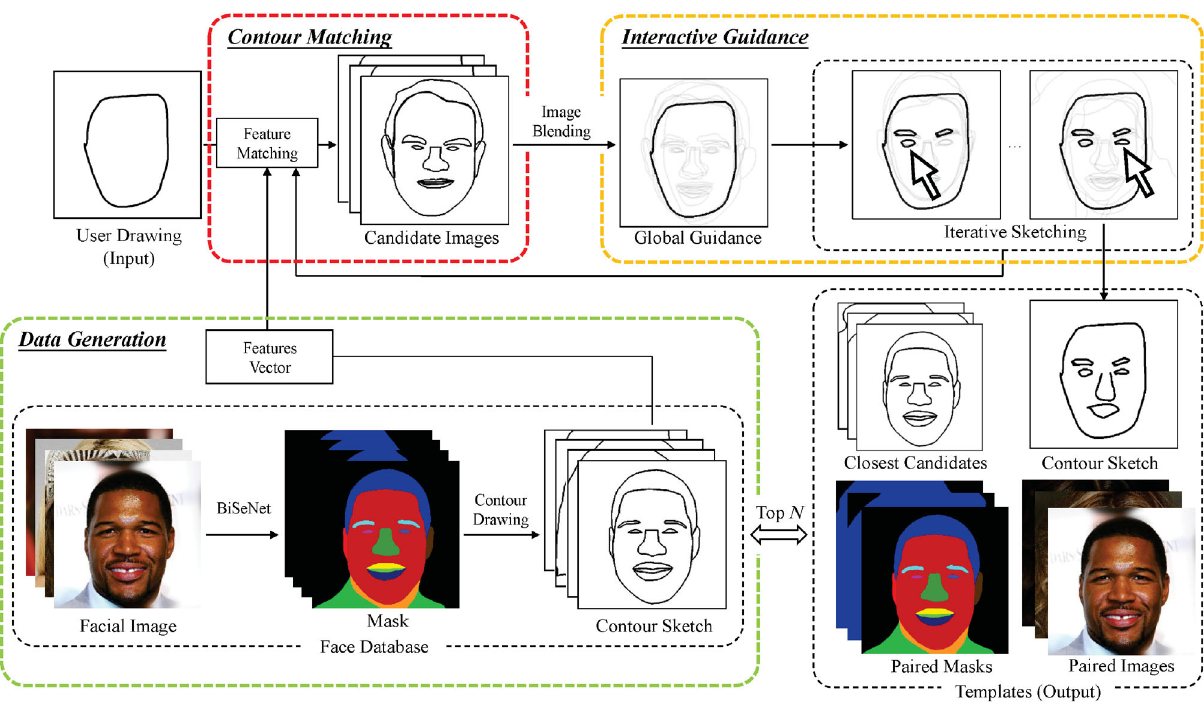
Fig. 3 Global guidance stage consists of three steps: data generation, contour matching, and interactive guidance. The contour sketches in our database are extracted from masks as source images, which are more meaningful for feature matching, and lead to better drawing guidance than previous work